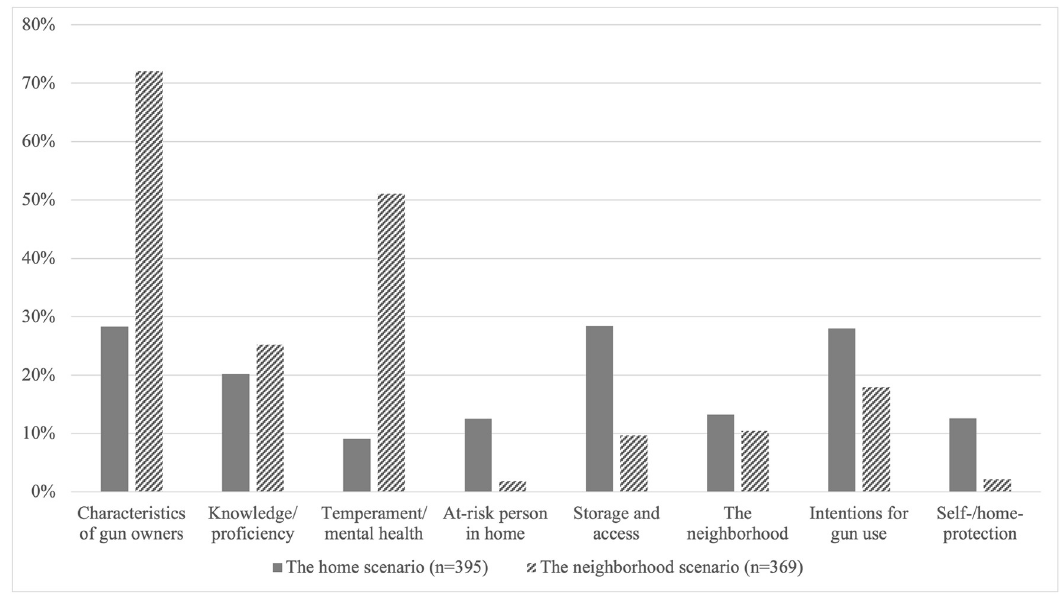
Fig 2. Factors on which perceptions of safety depend: The home scenario vs the neighborhood